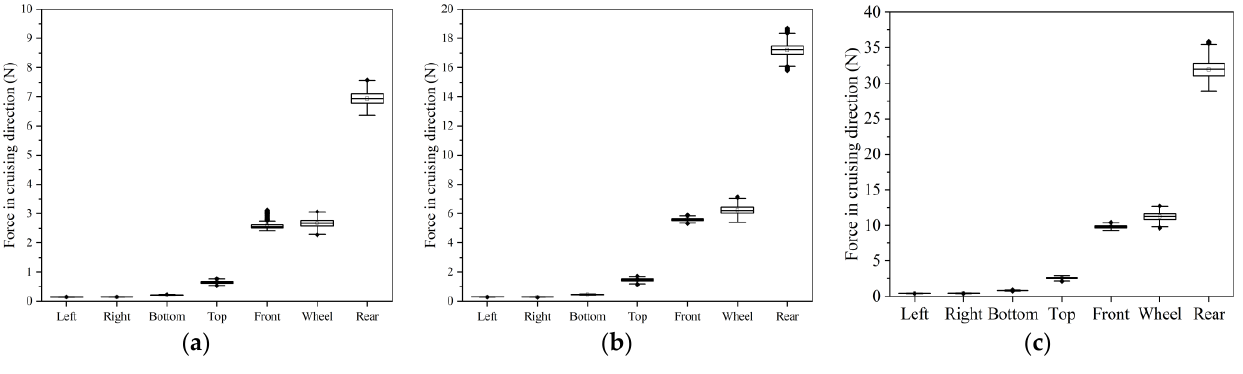
Figure 6. F X forces on the bus at ( a ) 10 km/h; ( b ) 15 km/h; ( c ) 20 km/h.